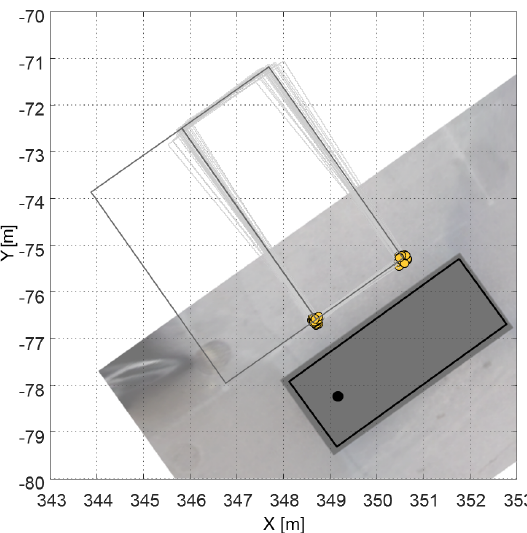
Figure 5. The parking spaces are generated through the sampled corner points; the yellow dots are sampled corner points, and the gray rectangles are the generated parking